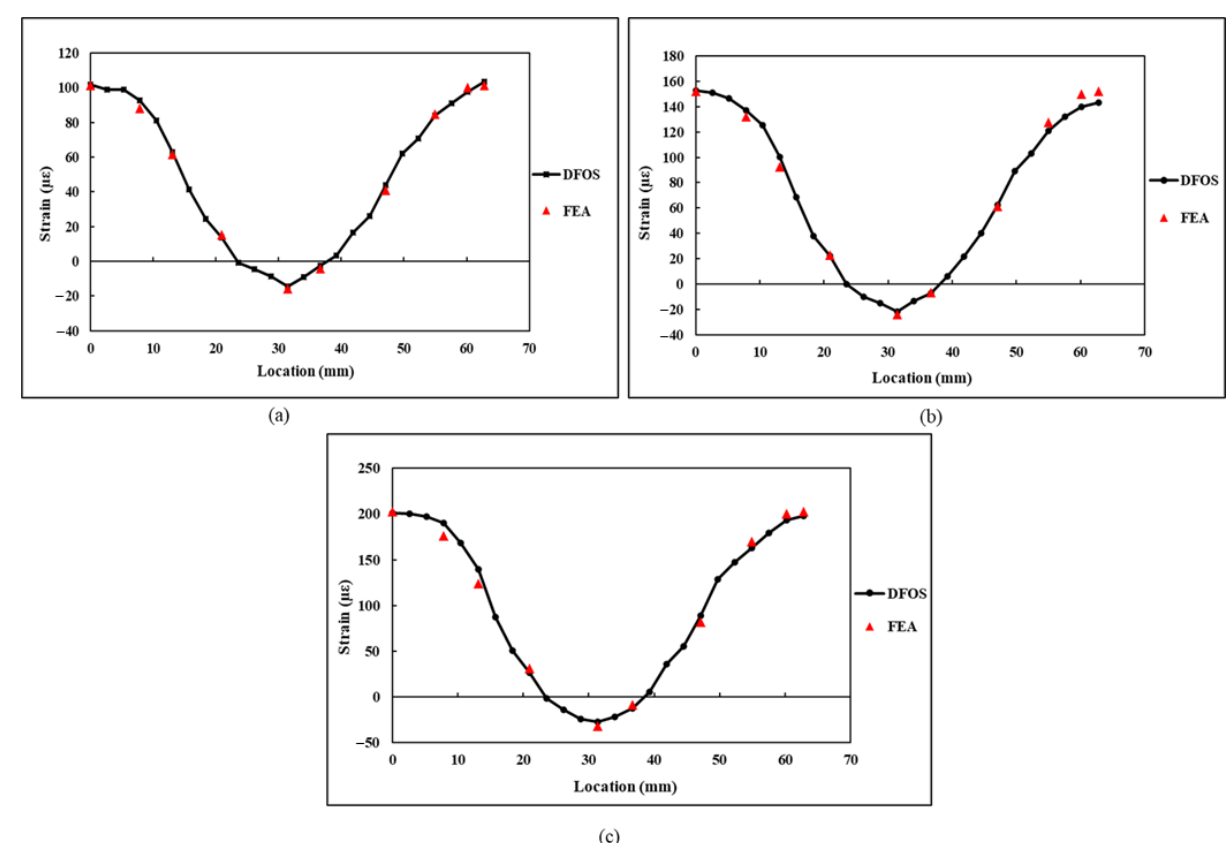
Figure 20. Comparison of the ε n1 − ε n10 values obtained in flexural specimen at a loading of: ( a ) 50 N; ( b ) 75 N; ( c ) 100 N.